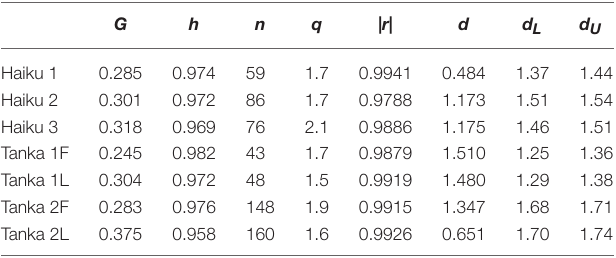
TABLE 13 | Rank-ordered frequency distribution of the sound arrangements in the full names of Japanese men registered in the database of Sapporo Gakuin University. Rank No. Arrangement Correlation Surveyed